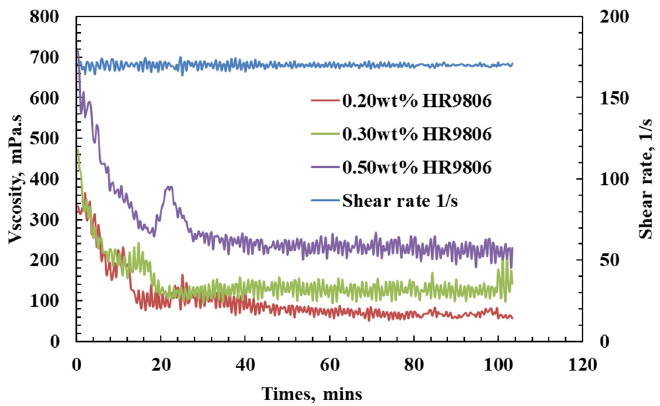
Figure 8. Shear resistance of 0.15 wt % crosslinker with different HR9806. 3.4.1. Plugging Performance Evaluation of Weak Gel System in Small Fractures The core length was 30.0 cm, and the fracture equivalent width was 0.0119 mm.